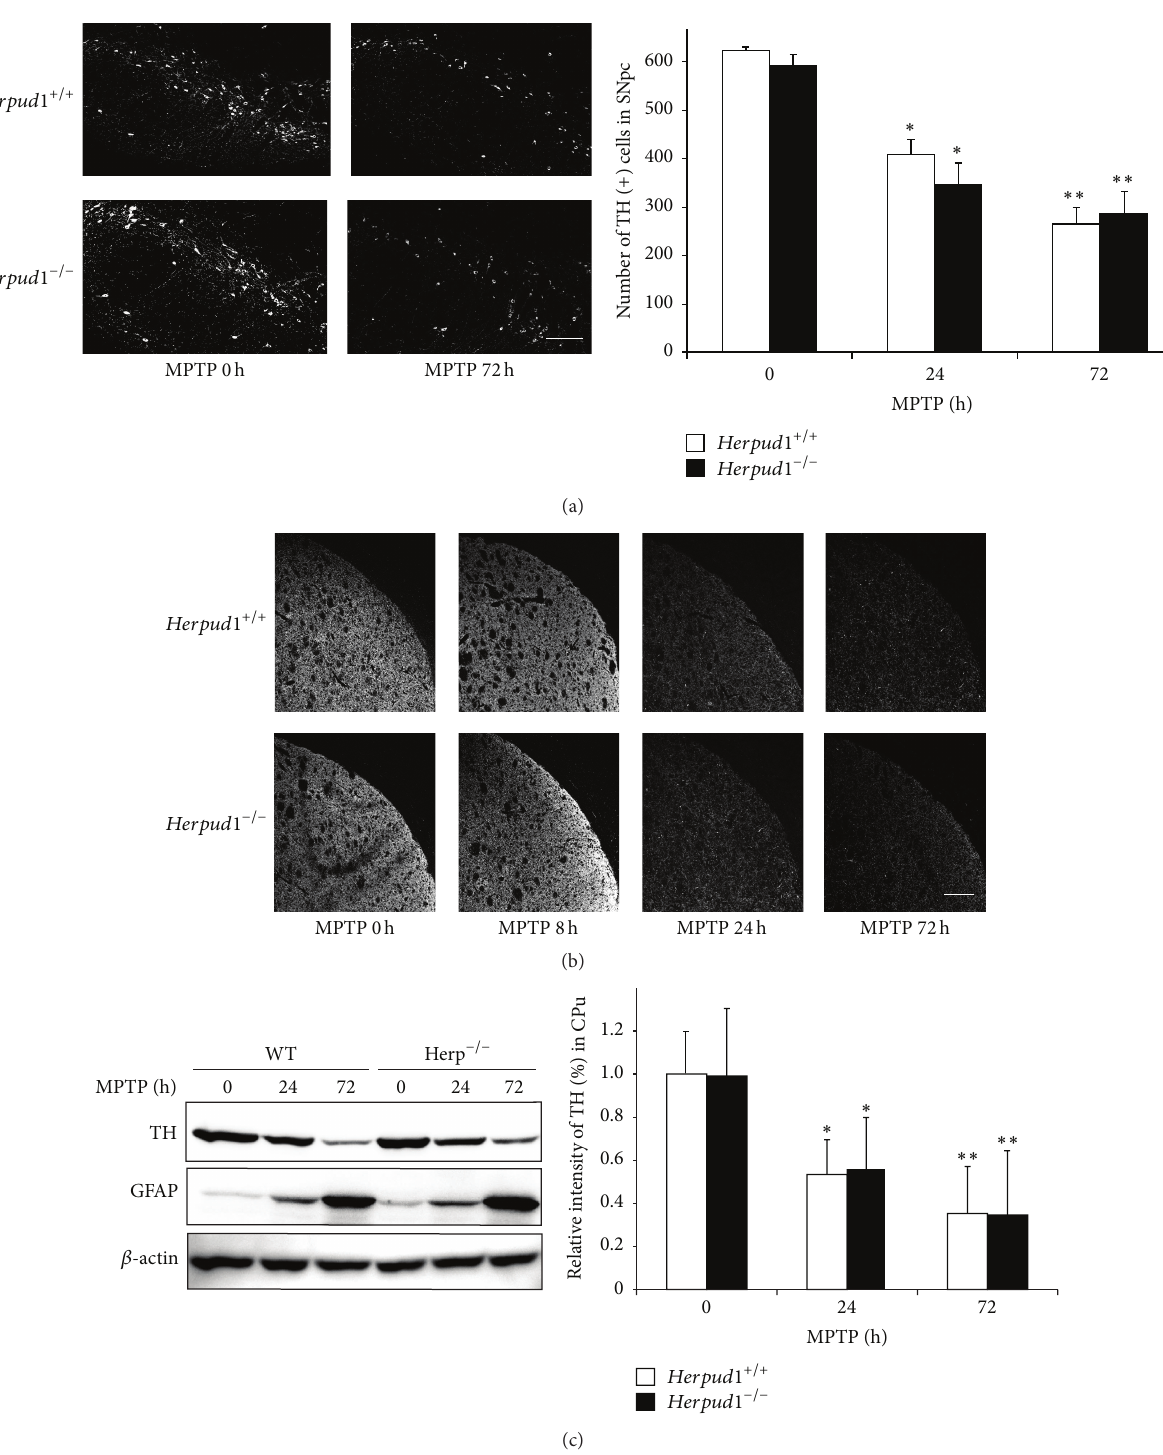
Figure 2: Neurodegeneration after MPTP administration. (a, b) Immunohistochemistry. Herpud1 +/+ and Herpud1 −/− mice were injected with MPTP and perfused with 4% paraformaldehyde at the indicated times. Brain sections, including sections with the SNpc (a) or CPu (b), were subjected to immunohistochemistry with anti-TH antibody. The number of TH-positive neurons in the SNpc is shown in (a). Values shown are the mean ± SD ( 𝑛 = 4 ). ∗∗ 𝑃 < 0.01 , compared to mice without MPTP administration. (c) Western blots. Herpud1 +/+ and Herpud1 −/− mice were injected with MPTP, and protein samples (30 𝜇 g) extracted from the CPu were subjected to western blotting with anti-TH, anti-GFAP, and anti- 𝛽 -actin antibodies. The relative intensity of TH is shown in the graph. Each value shown is the mean ± SD ( 𝑛 = 4 ), and the value derived from Herpud1 +/+ mice without MPTP injection is designated as one. ∗ 𝑃 < 0.05 , compared to mice without MPTP administration. Scale bars = 100 𝜇